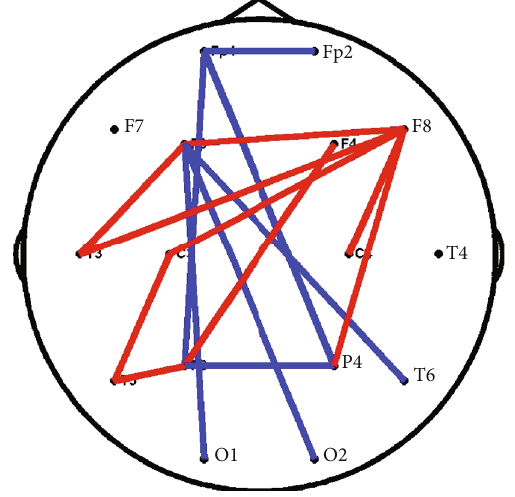
Figure 3: Topological di ff erences between pre- and postseizure. The red and blue solid lines denote signi fi cantly ( p < 0 : 05 ) enhanced and weakened functional connectivity postseizure,